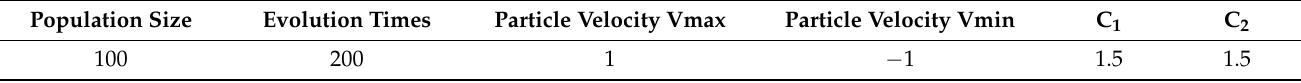
Table 3. Parameters in